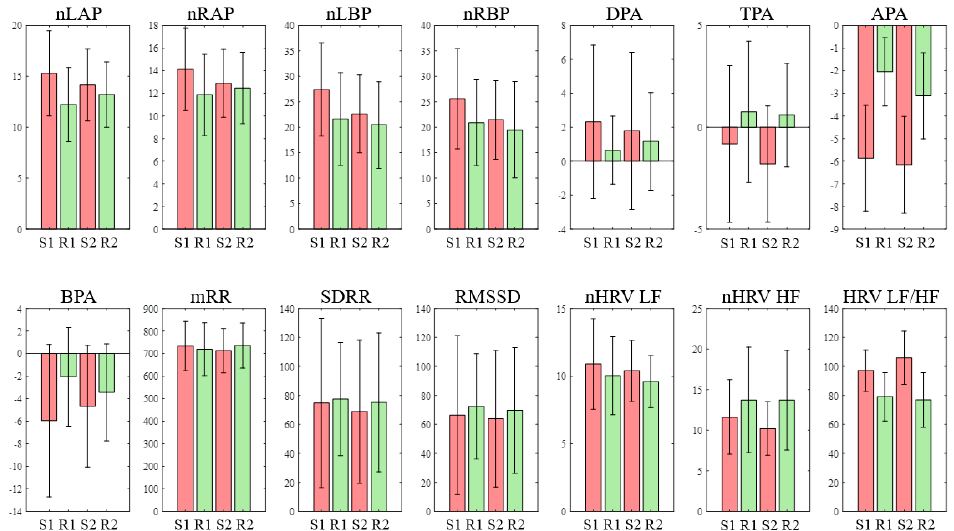
(R2 versus S1 and R2 versus S2) ( p < 0.05).